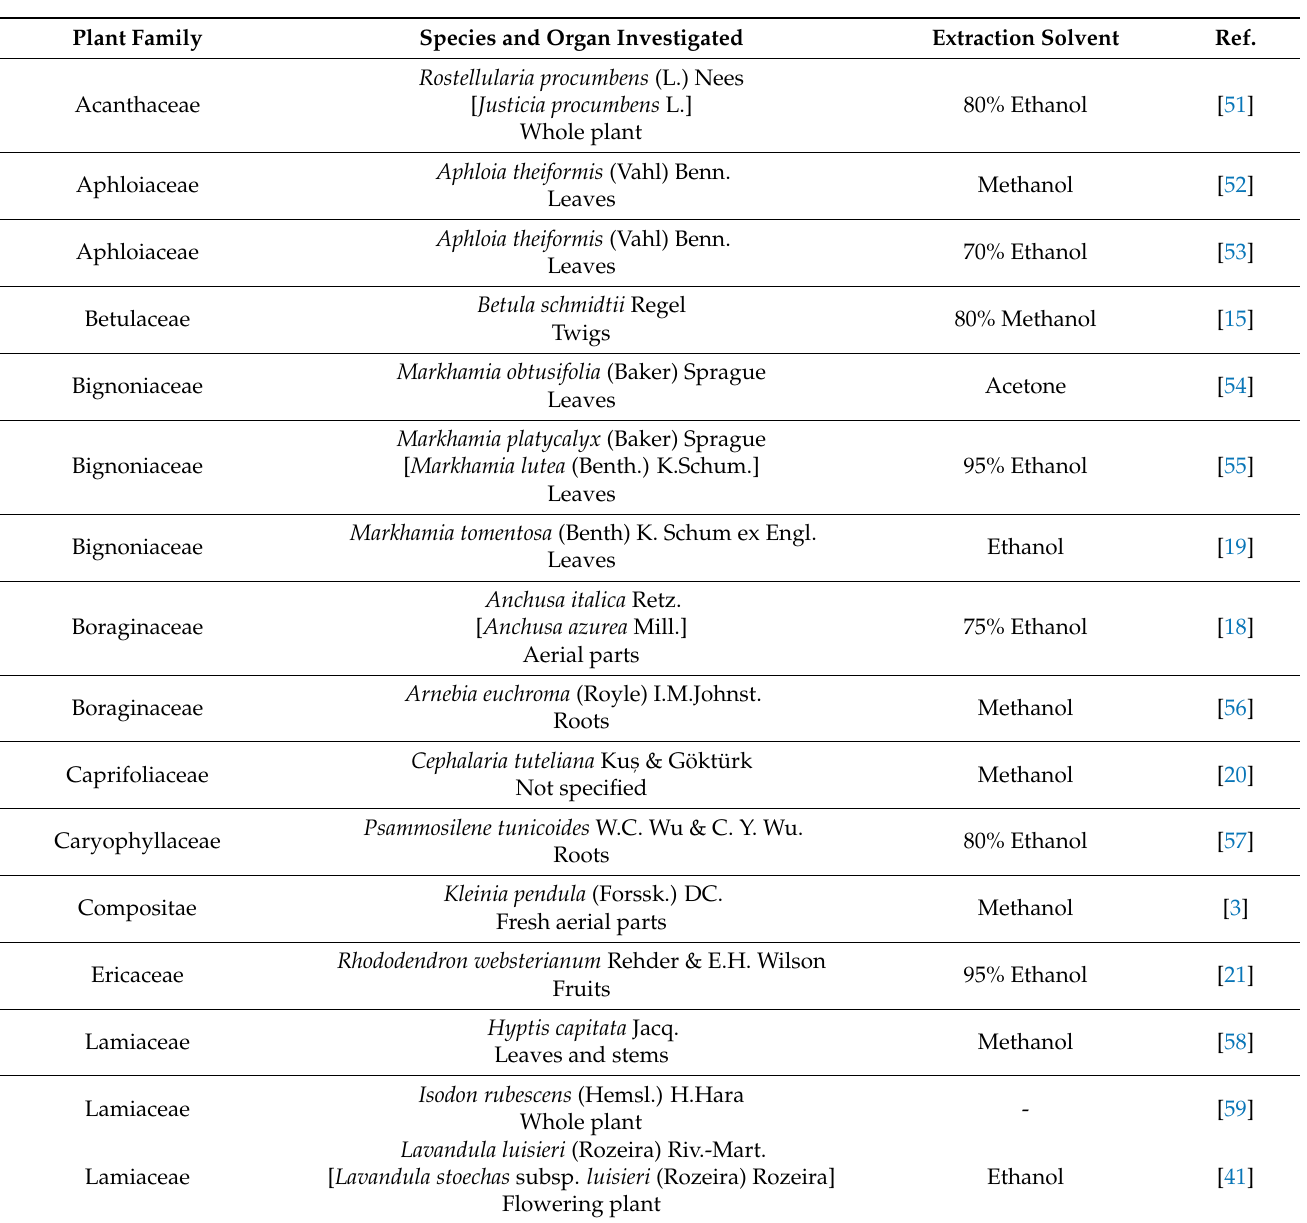
Table 1. Confirmed botanical sources of tormentic acid (currently accepted botanical names (where applicable) according to www.theplantlist.org (accessed on 12 April 2021) are given in square brackets) and initial extrahent type used for elution of TA from plant